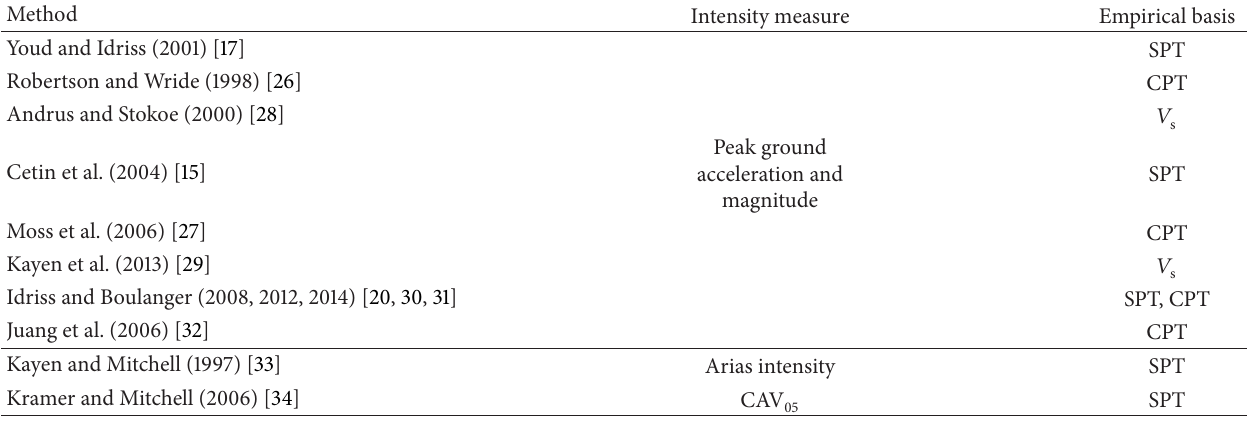
Table 3: Liquefaction potential evaluation methods compared in the analysis.